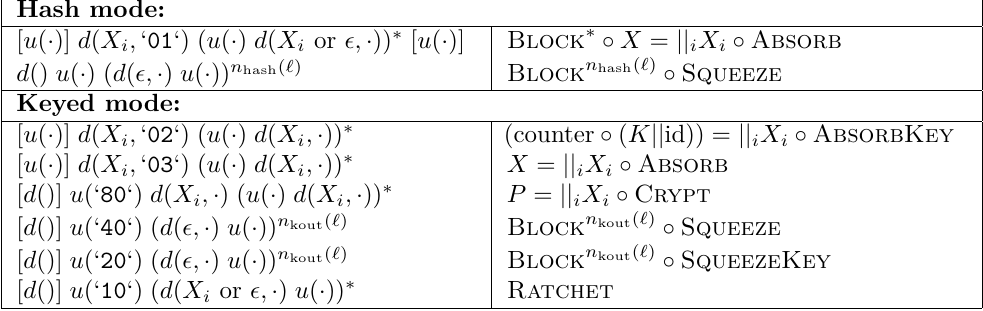
Table 2: Matching up and down sub-sequences with process history. Here u () and d () are shortcut notations for Up () and Down (),